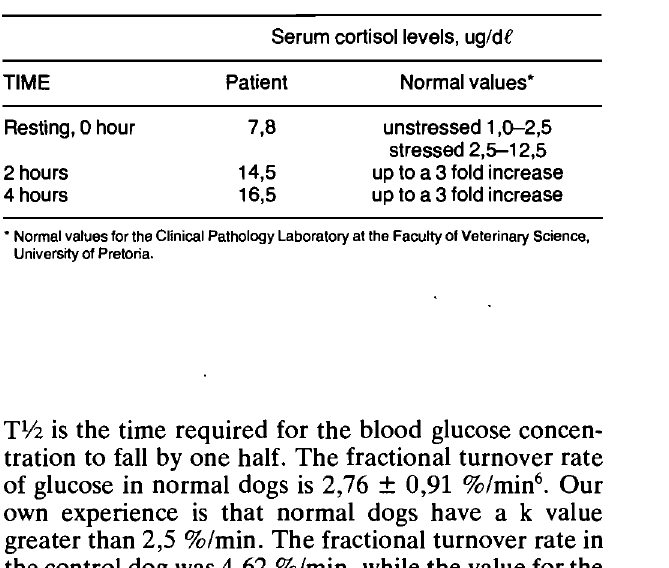
Table 3: CORTICOTROPIN STIMULATION TEST